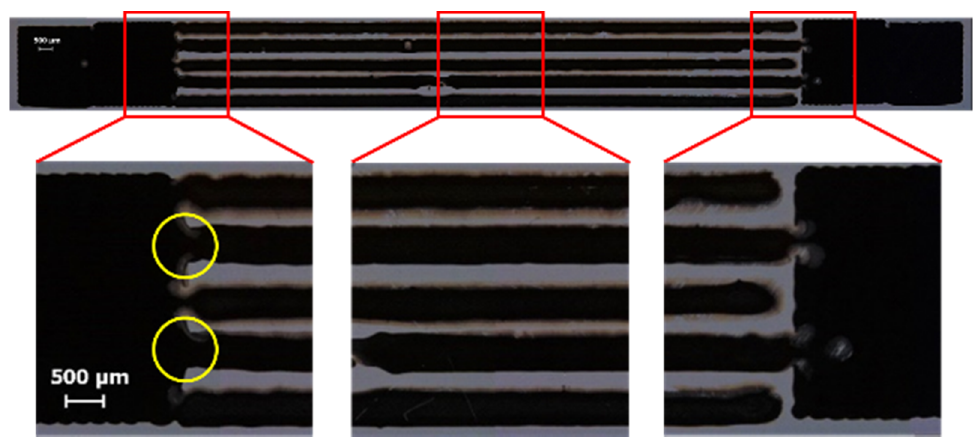
Figure 9. Example of printed sample with interconnected comb shapes ( Δ x = 80 µm, Δ y = 110 µm, v p = 10 mm/s, T n = 40 °C).